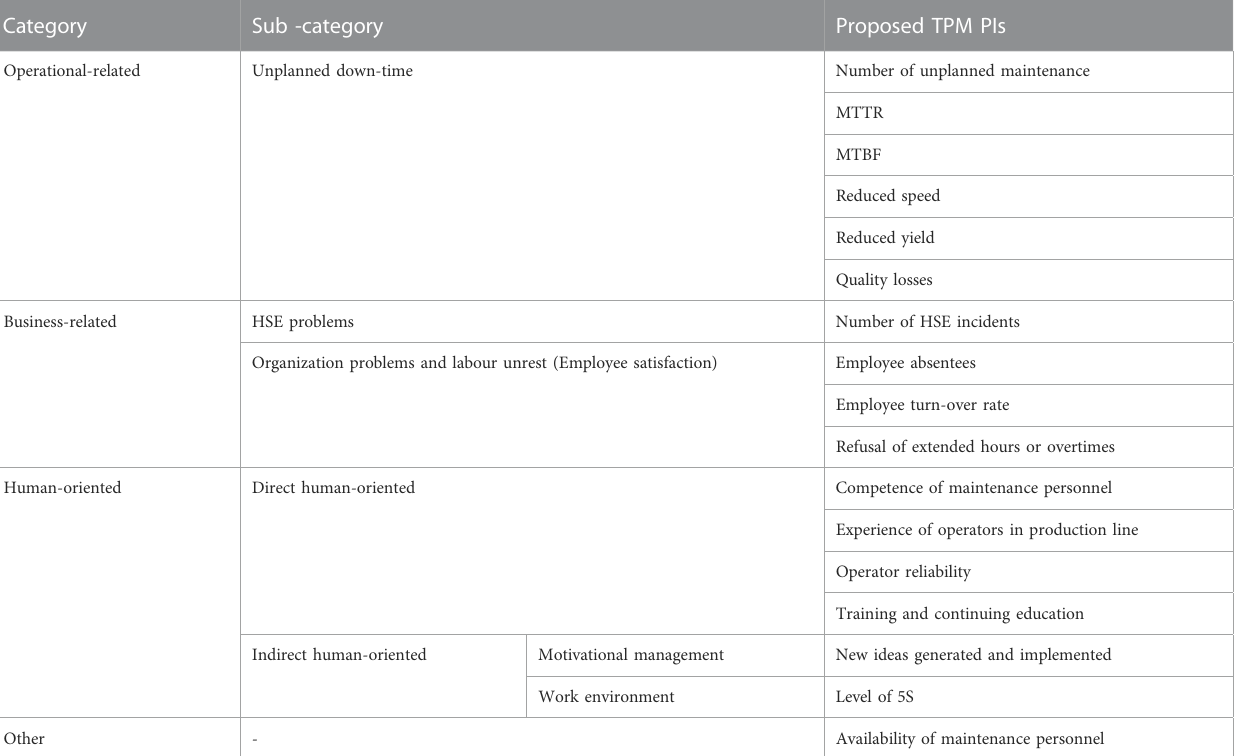
TABLE 3 A detailed list for the proposed TPM PIs.